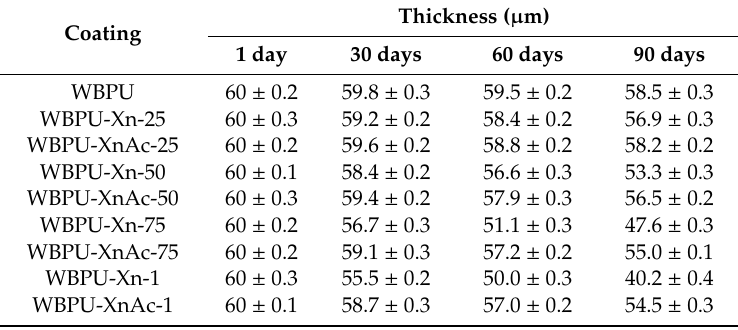
Figure 7. Molecular weight of typical coatings at different conditions. Table 5. Thickness of immersed coatings at defined interval (day).